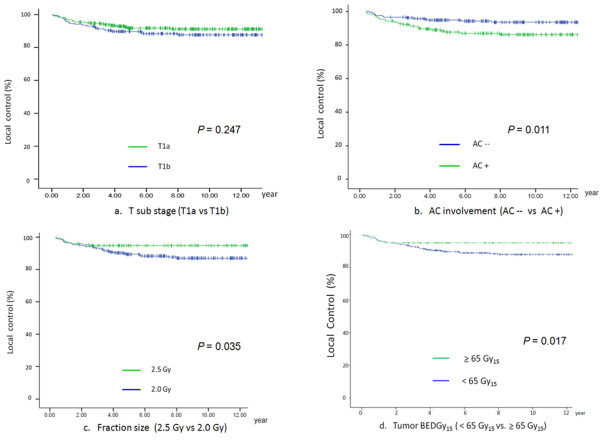
Local control rate according to T sub-stage; AC involvement; Fraction size; tumor BEDGy15. a. T sub stage (T1a vs T1b). b. AC involvement (AC - vs AC +). c. fraction size (2.5 Gy vs 2.0 Gy). d. Tumor BEDGy15 (<65 Gy15 vs ≧ 65 Gy15). Abbreviations: AC: anterior commissure; AC--: absence of AC involvement; AC+: presence of AC involvement; BED: biologically effective dose.